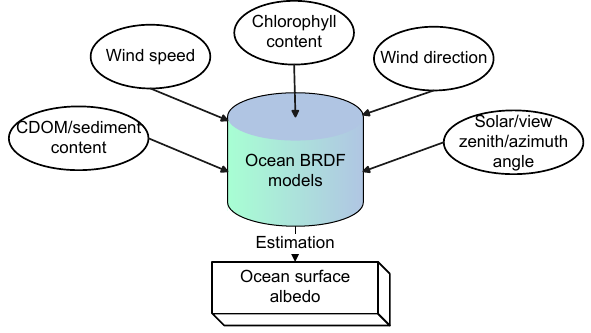
Fig. 1 Flowchart of the estimation method based on reanalysis data